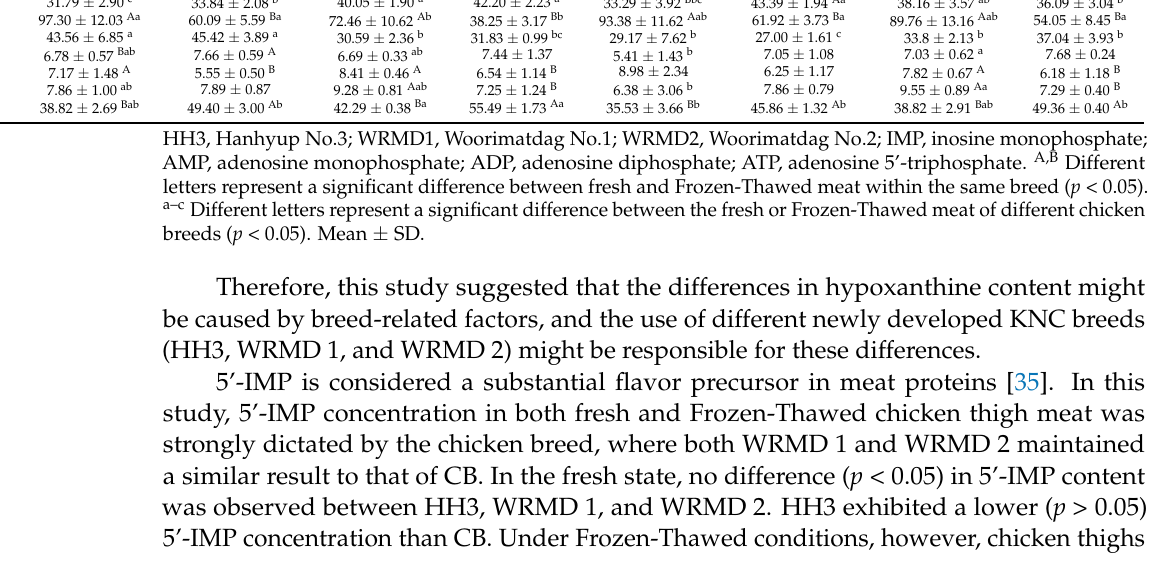
Table 3. Comparison of nucleotide-related compounds contents of fresh and Frozen-Thawed chicken meats from Korean native chickens and broilers. Nucleotide-Related